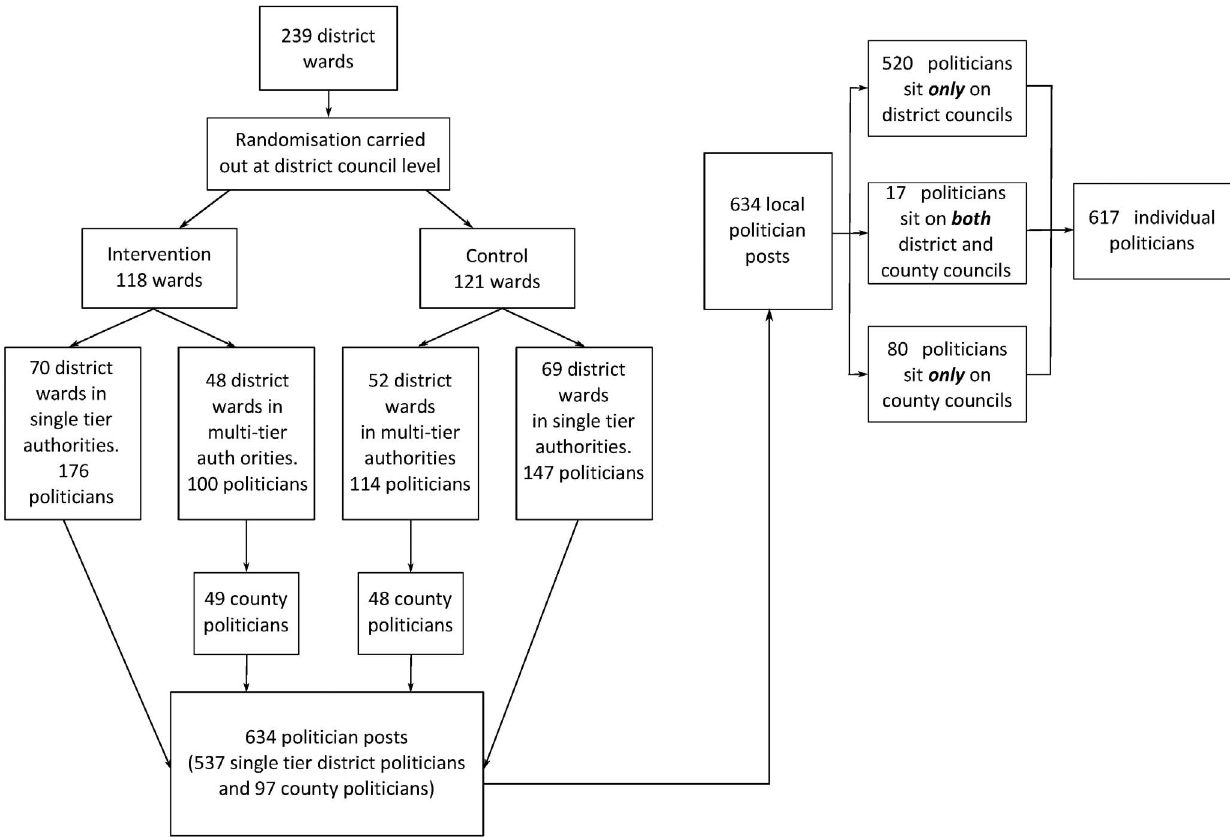
Figure 1. Distribution of local politicians (district and/or county) between intervention and control local authorities and electoral wards.